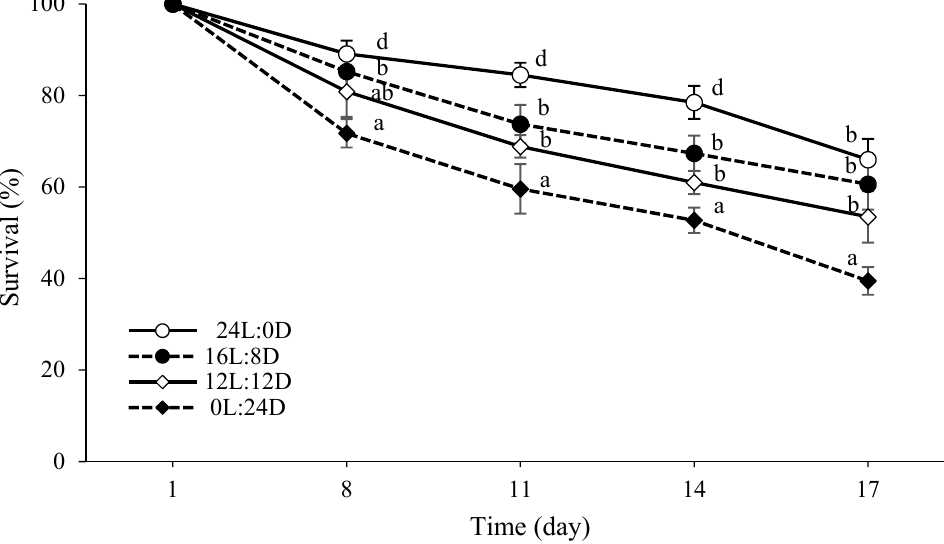
Figure 2. Comparison of survival rate of B. orientalis under different photoperiod regimes (mean ± SD, n = 3). Different superscript letters denote statistically significant differences at each timepoint ( p < 0.05).